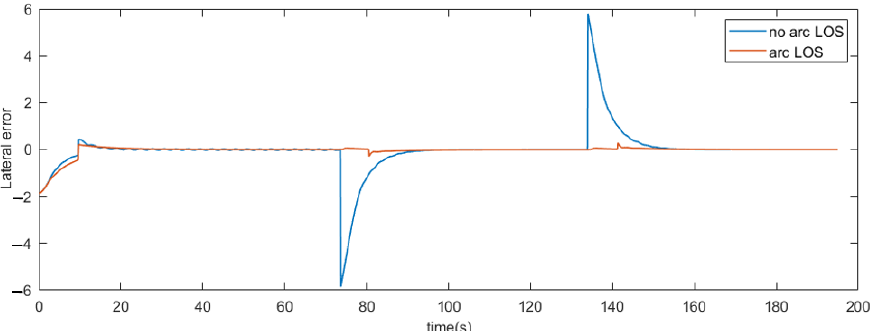
Figure 12. Comparison of lateral errors in path tracking between the two methods.